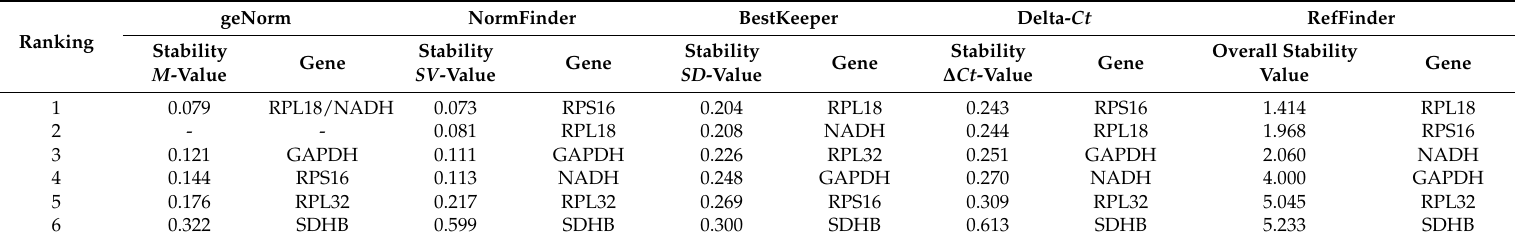
Table 3. Ranking of candidate reference genes according to stability values evaluated in tissues of A.